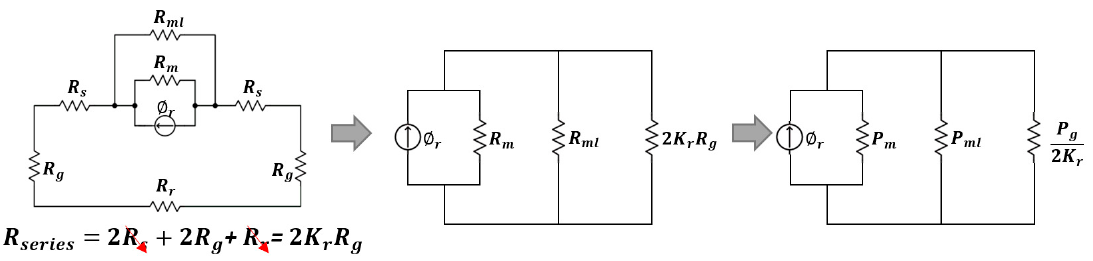
Figure 3. The magnetic circuit of FSPM.